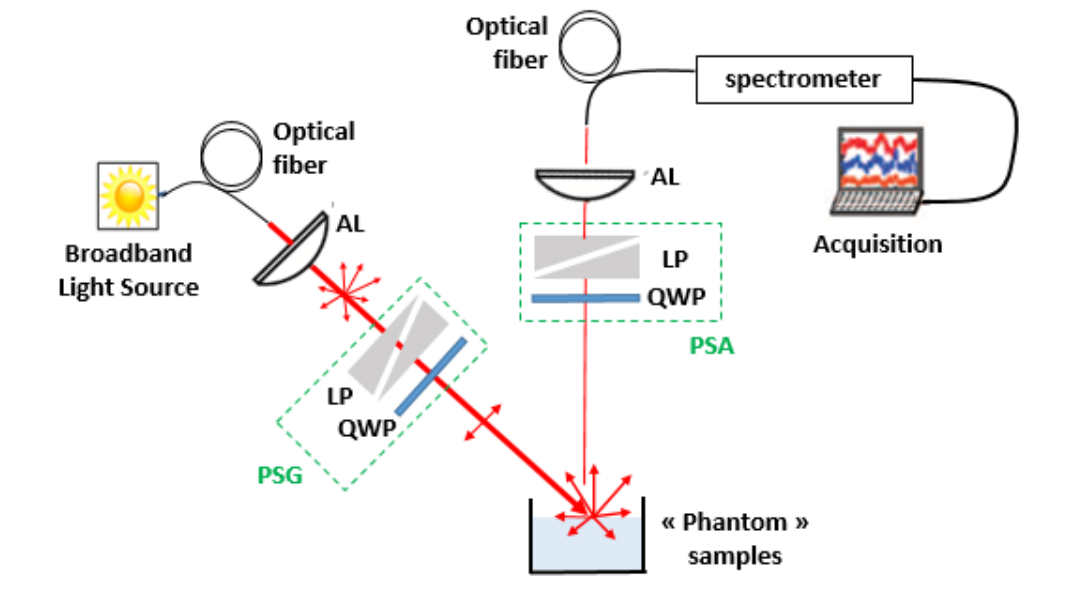
Figure 2. Schematic representation of PoLiS system in reflectance with PSG (polarization state generator), PSA (polarization state analyzer), LP (linear polarizer), QWP (quarter-wave plate) and AL (aspheric lens).